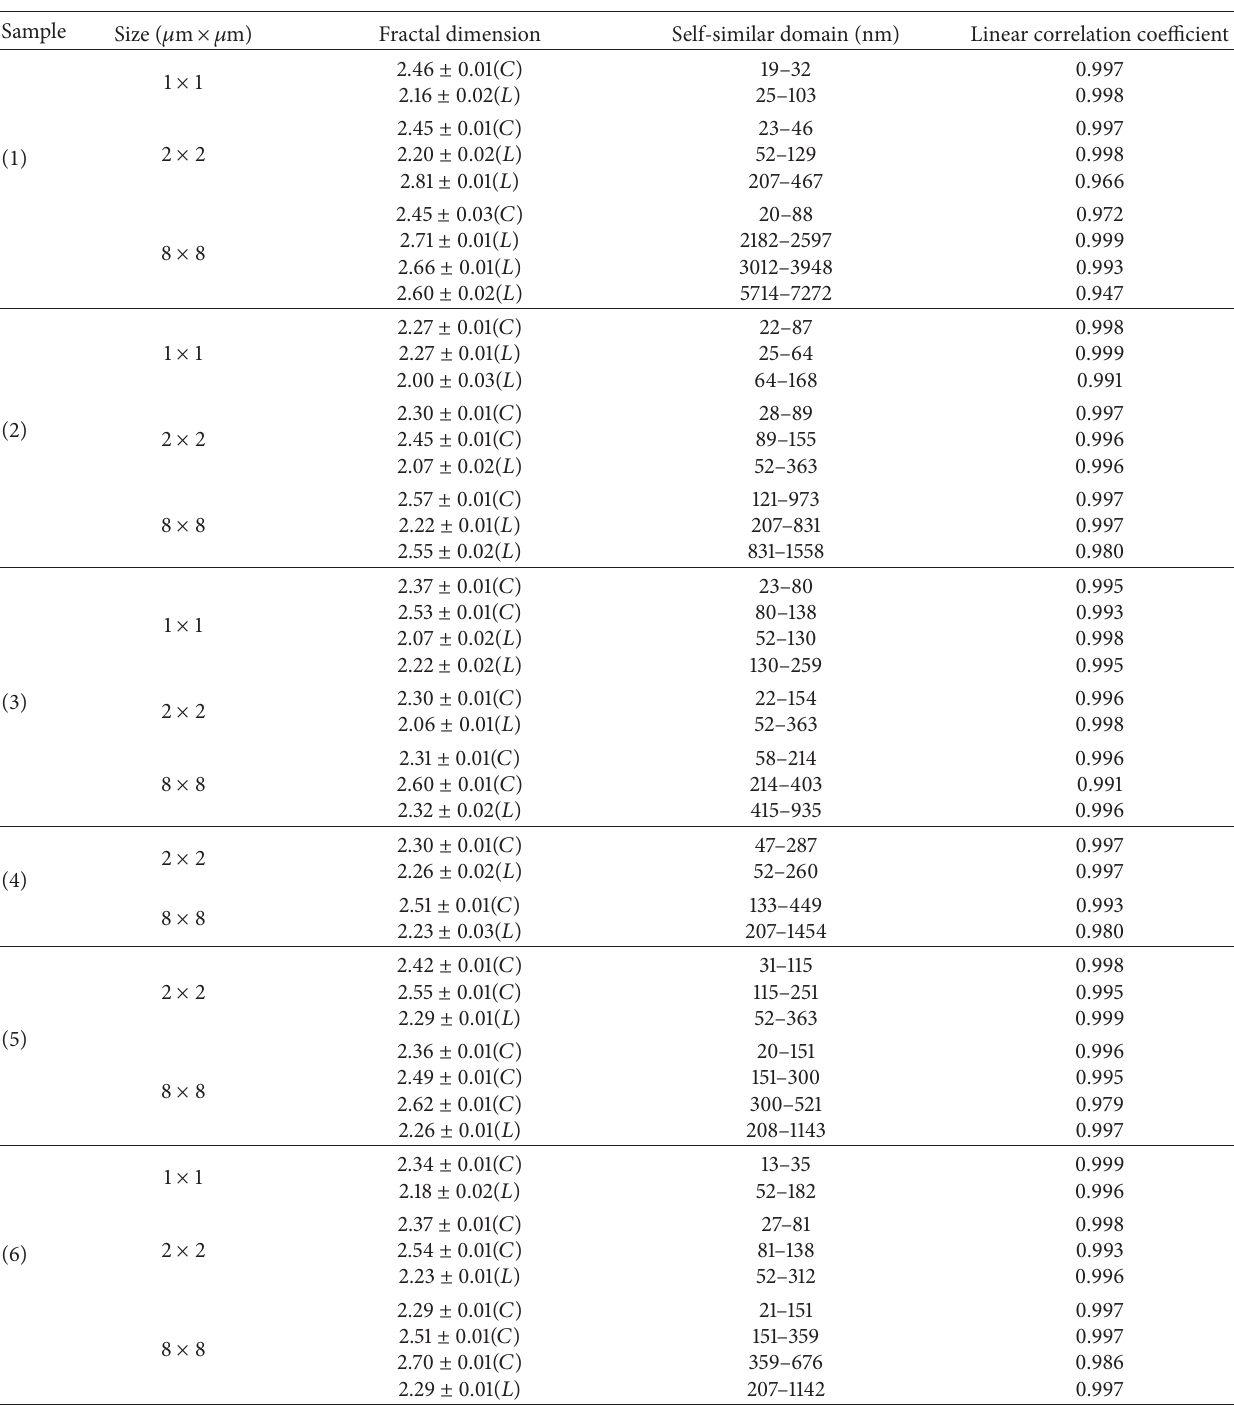
Table 1: Fractal dimensions and self-similarity domains for samples ( 1 )–( 6 ): ( 1 ) TMHAPP; ( 2 ) THAPP; ( 3 ) MHTPP; ( 4 ) TMDOPP; ( 5 ) TMDPP; and ( 6 )